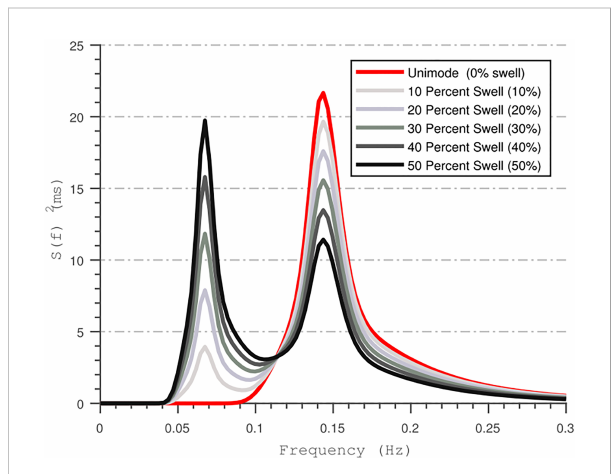
FIGURE 3 An example of energy-conserved bimodal spectrum. From Figure 3 of Orimoloye et al. (2019).